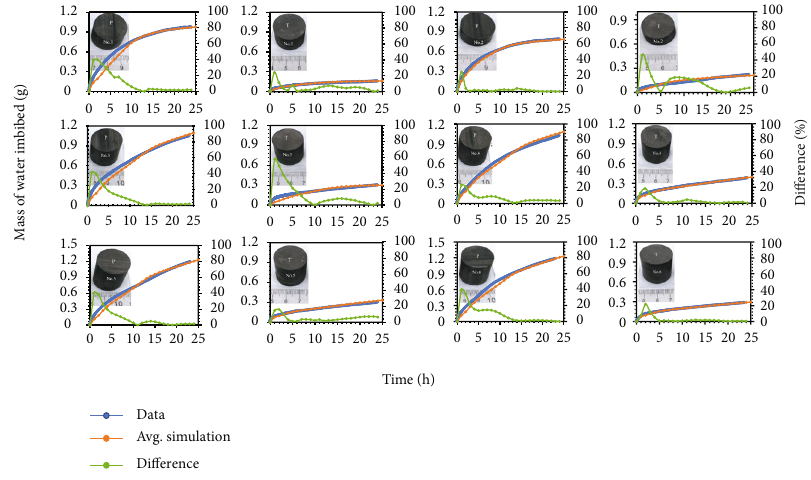
Figure 15: Comparison of mass of imbibed water over time in Barnett Shale